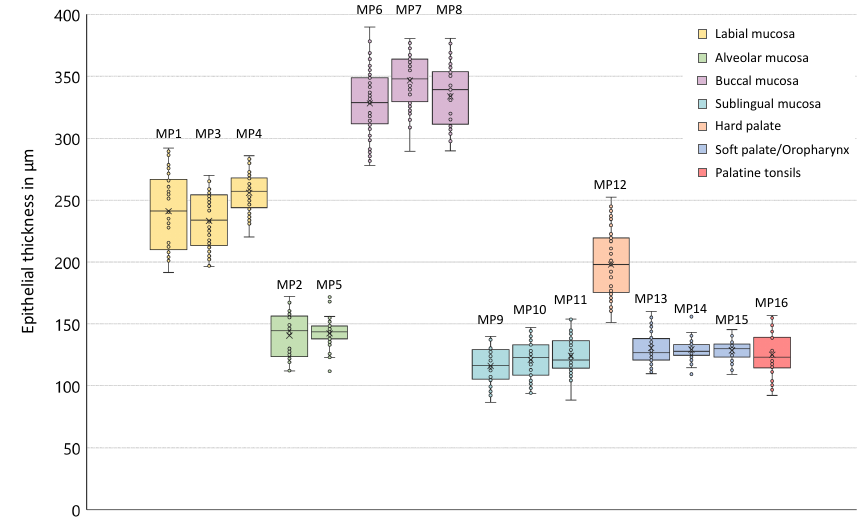
Figure 5. Box plots of the epithelial thickness (age- and gender-independent). The results for all measurement points are presented by colored boxes in accordance with the corresponding investigation areas (cp.Figure 1). The sample median is depicted as central line inside the boxes, the sample mean value corresponds to the cross. The individual mean values are illustrated by circles. The width of the box is equivalent to the interquartile range. Maximum and minimum of the sample are shown by the